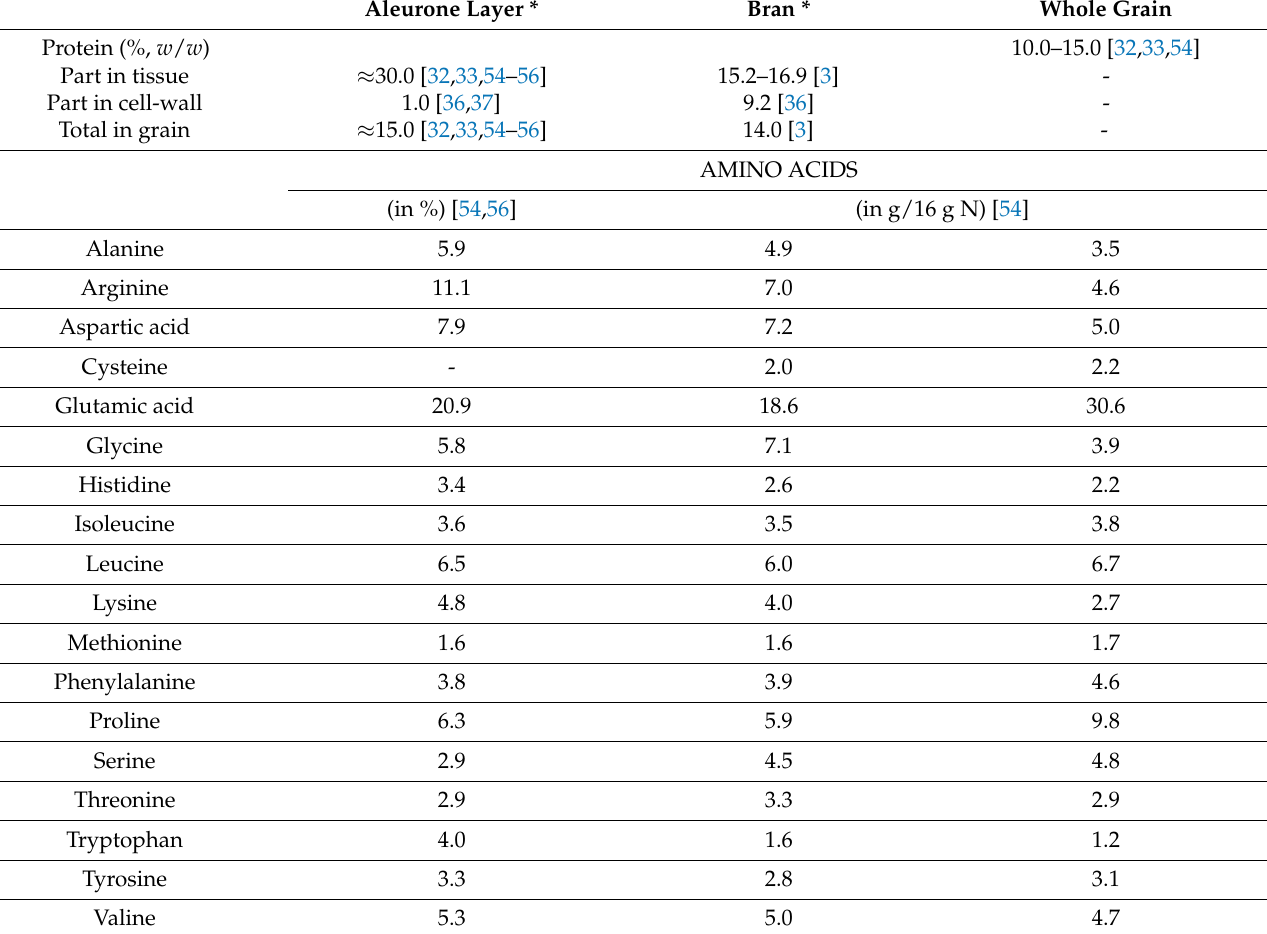
Table 3. Proteins and amino acids repartition in the wheat aleurone layer, bran and whole